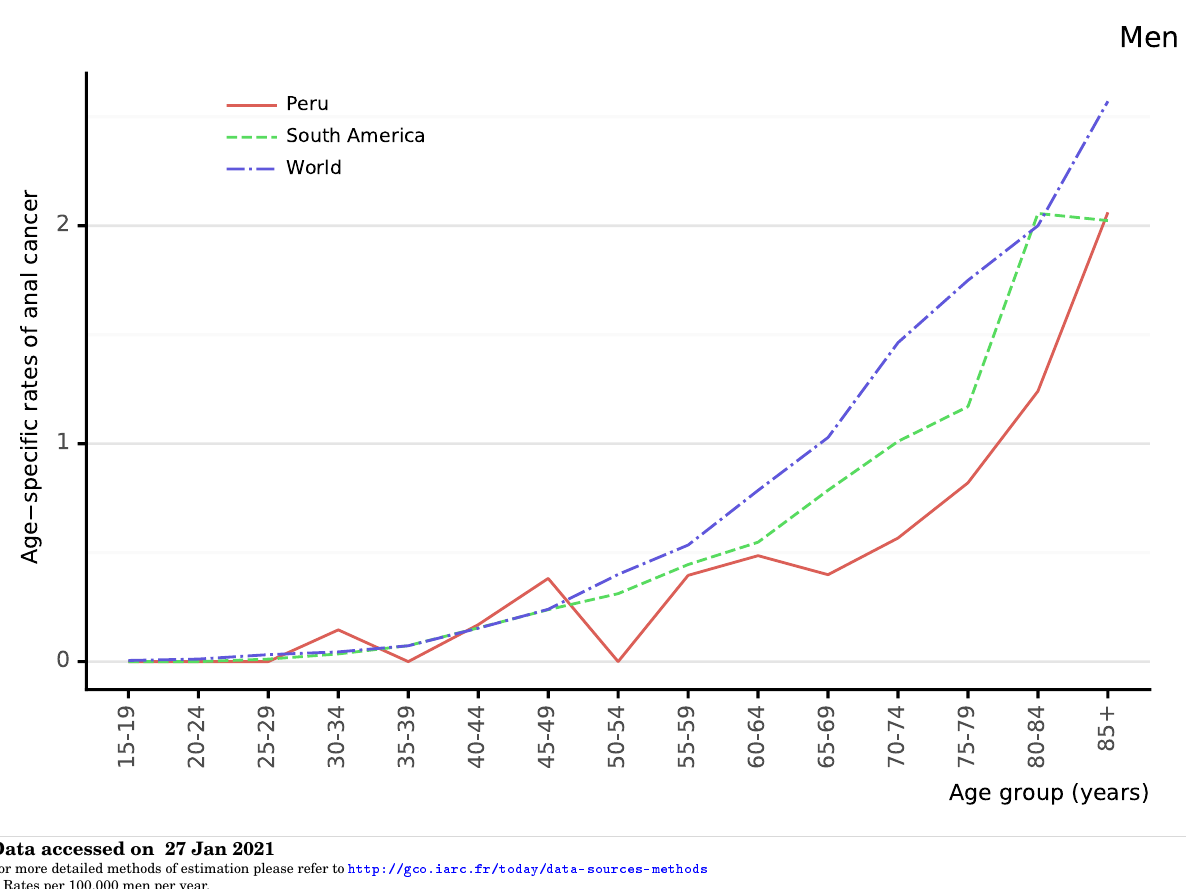
Figure 111: Comparison of age-specific anal cancer mortality rates among men by age in Peru, within the region, and the rest of